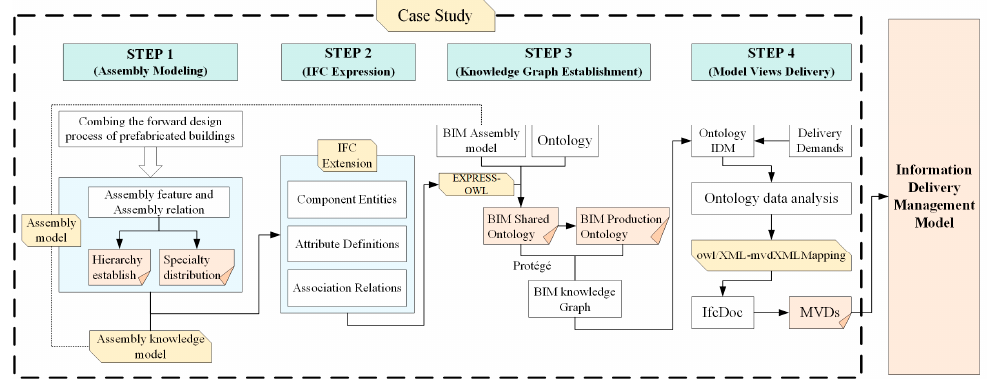
Figure 2. An overall research